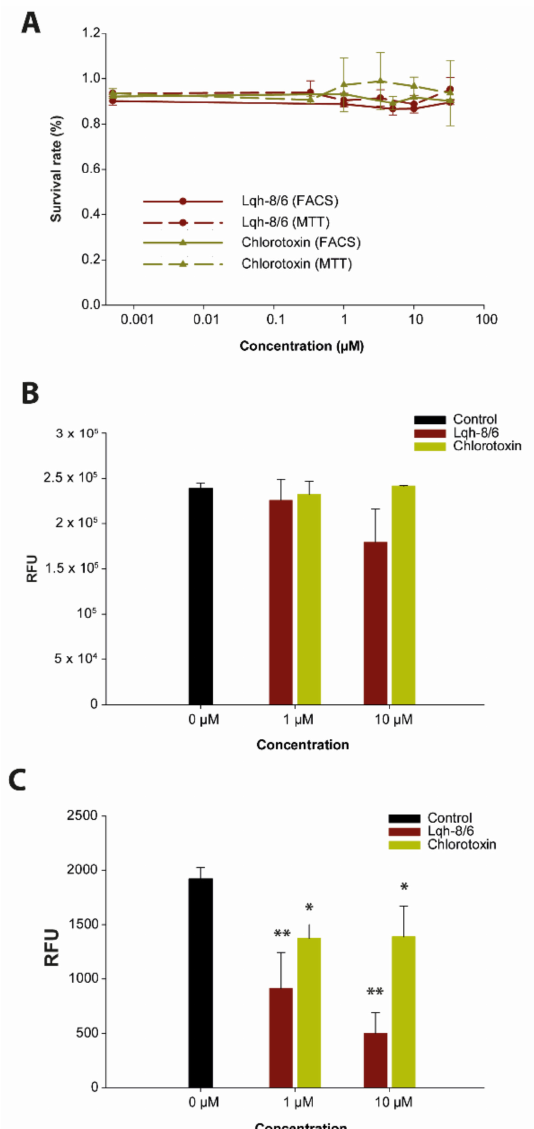
Figure 3. Functional effects of chlorotoxin and Lqh-8/6 onto F98 cells in culture. ( A ) Lack of cell toxicity of chlorotoxin and Lqh-8/6 as assessed by MTT assay and flow cytometry. Toxicity results from flow cytometry data (calcein for living cells and ethidium homodimer for dead cells) are represented by full lines, whereas MTT results are shown with dashed lines. ( B ) Effect of chlorotoxin and Lqh-8/6 on F98 cell migration. RFU: Relative Fluorescence Unit. ( C ) Effect of chlorotoxin and Lqh-8/6 on F98 cell invasion. * p ≤ 0.07; ** p ≤